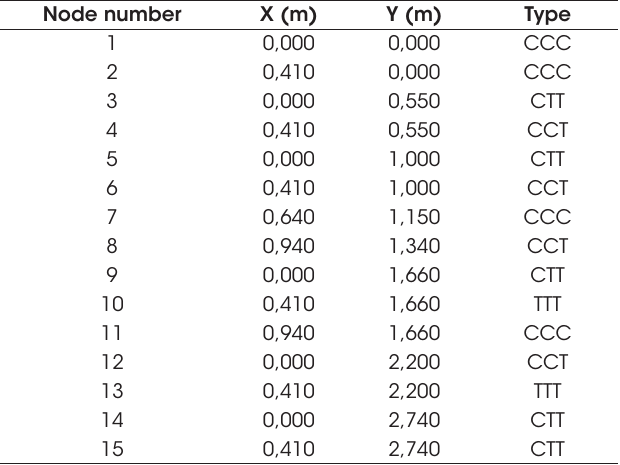
the proposed model. The design of the reinforcement was based on the Brazilian standard [6] and the considered steel was the CA50.